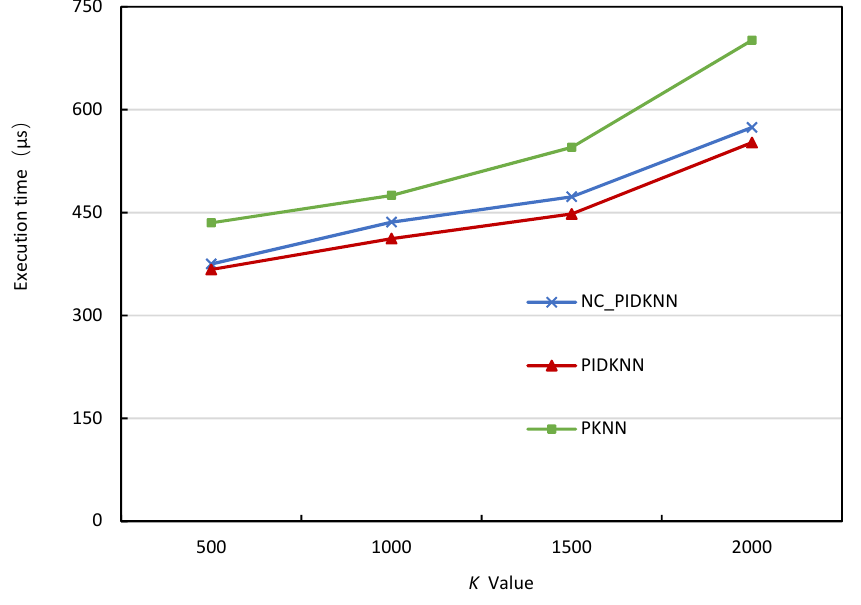
Figure 5. Execution time vs. k values.